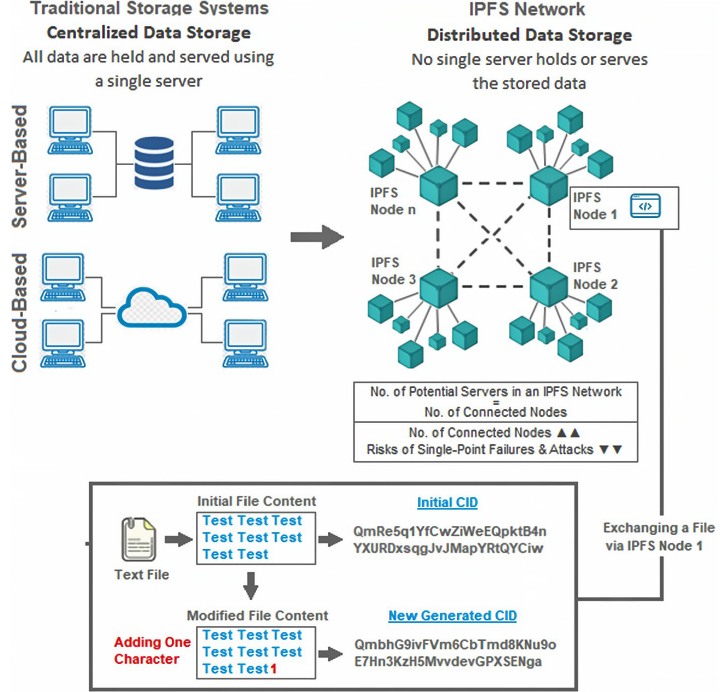
Figure 2. Traditional storage systems and IPFS